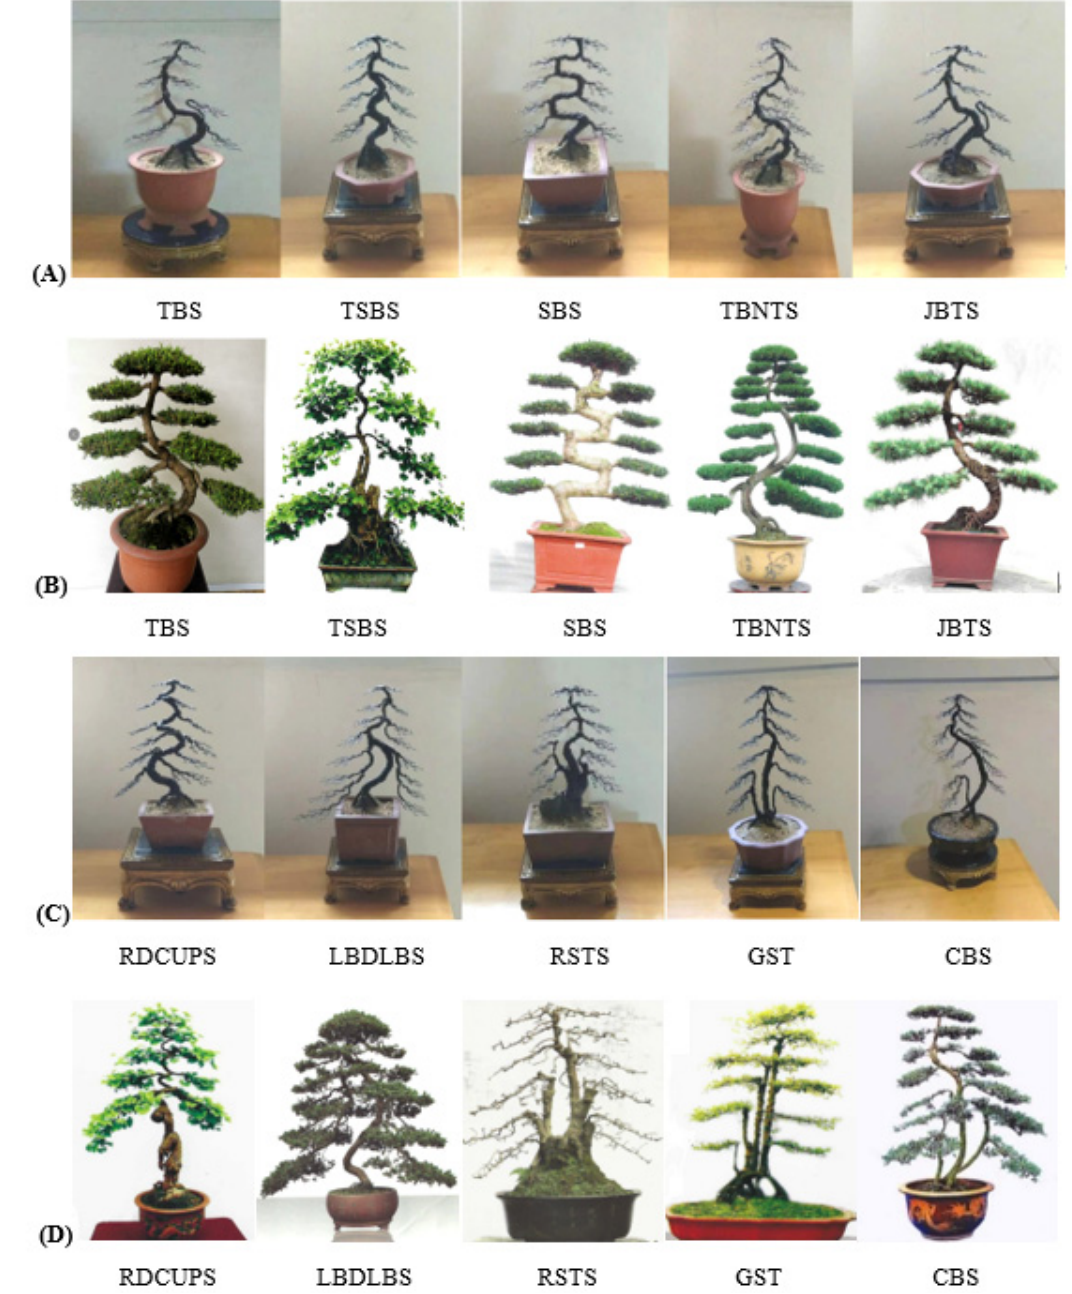
Figure 1. The standard models ( A , C ) and plant shapes ( B , D ) of the Sichuan regular potted landscapes. Note: The above images depict the ten techniques of regular-style Sichuan potted landscapes, including the Turn and Bend Skill (TBS, Chinese name ‘ 掉 拐 法 ’), the Turning Symmetrical Bend Skill (TSBS, Chinese name ‘ 对 拐 法 ’), the Square Bend Skill (SBS, Chinese name ‘ 方 拐 法 ’), the Three Bends and Nine Turn Skill (TBNTS, Chinese name ‘ 三 弯 九 拐 法 ’), the Joining the Bending and Turning Skill (JBTS, Chinese name ‘ 接 弯 掉 拐 法 ’), the Rolling Dragon Coil Up the Upright Post Skill (RDCUPS, Chinese name ‘ 滚 龙 抱 柱 法 ’), the Large Bends and Drooping Longer Branches Skill (LBDLBS, Chinese name ‘ 大 弯 垂 枝 法 ’), the Root Stump to the Top Skill (RSTS, Chinese name ‘ 逗 身 照 篼 法 ’), the Graft Straight Trunk Skill (GSTS, Chinese name ‘ 直 身 逗 顶 法 ’), and the Cleverly Borrowing Skill (CBS, Chinese name ‘ 巧 借 法 ’). The same applies